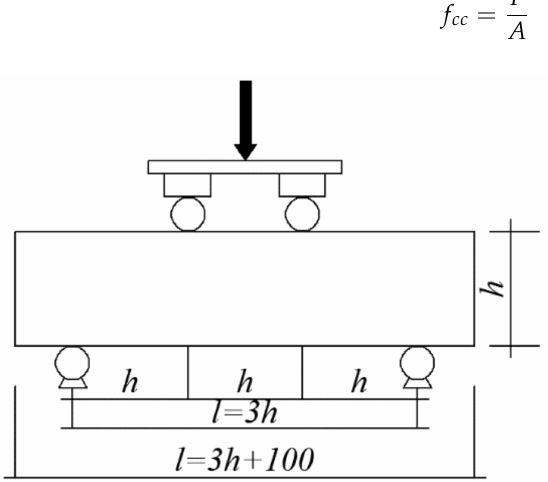
Figure 1. Loading device diagram of flexural strength test